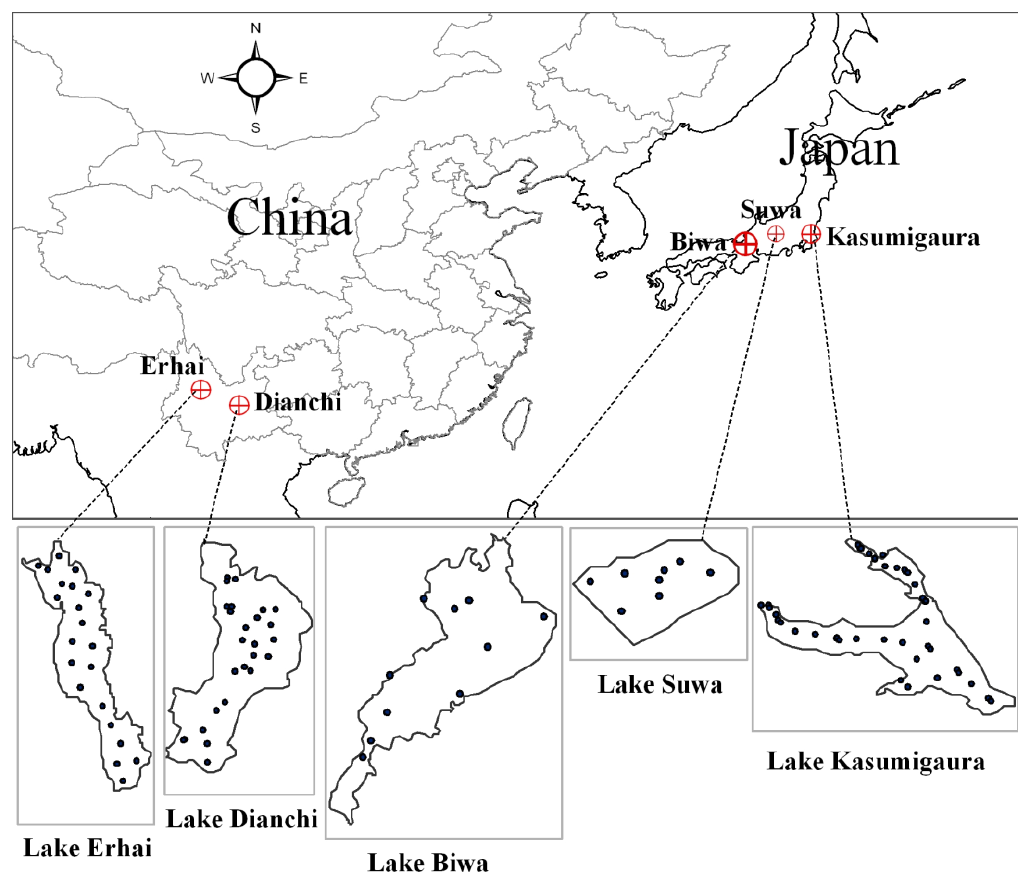
Figure 1. Distribution of sampling sites in Lakes Erhai and Dianchi of China; and Lakes Biwa, Suwa and Kasumigaura of